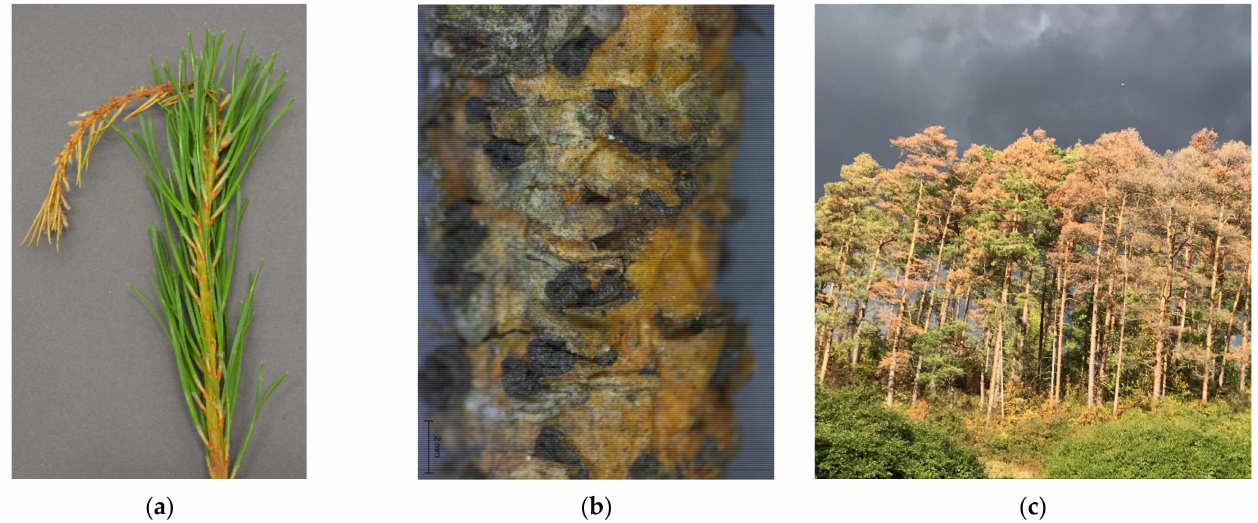
Figure 1. Sphaeropsis sapinea —Diplodia tip blight symptoms: ( a ) diseased Scots pine twig with dieback of the current shoot; ( b ) after seedling blight, black pycnidia can be observed on the twigs; ( c ) affected Scots pine stand in